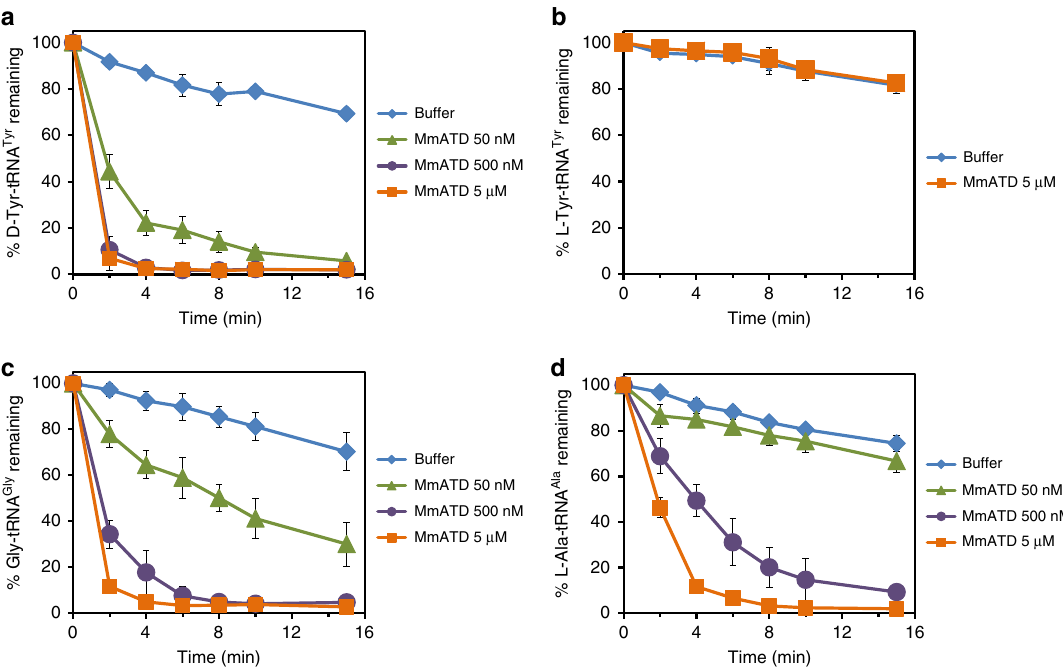
Fig. 4 ATD displays relaxation of substrate chiral speci fi city. a – d Deacylation of D -Tyr-tRNA Tyr , L -Tyr-tRNA Tyr , Gly-tRNA Gly and L -Ala-tRNA Ala by different concentrations of MmATD. Aminoacyl-tRNAs were used at 200 nM fi nal concentration. Error bars denote one standard deviation from the mean of three independent